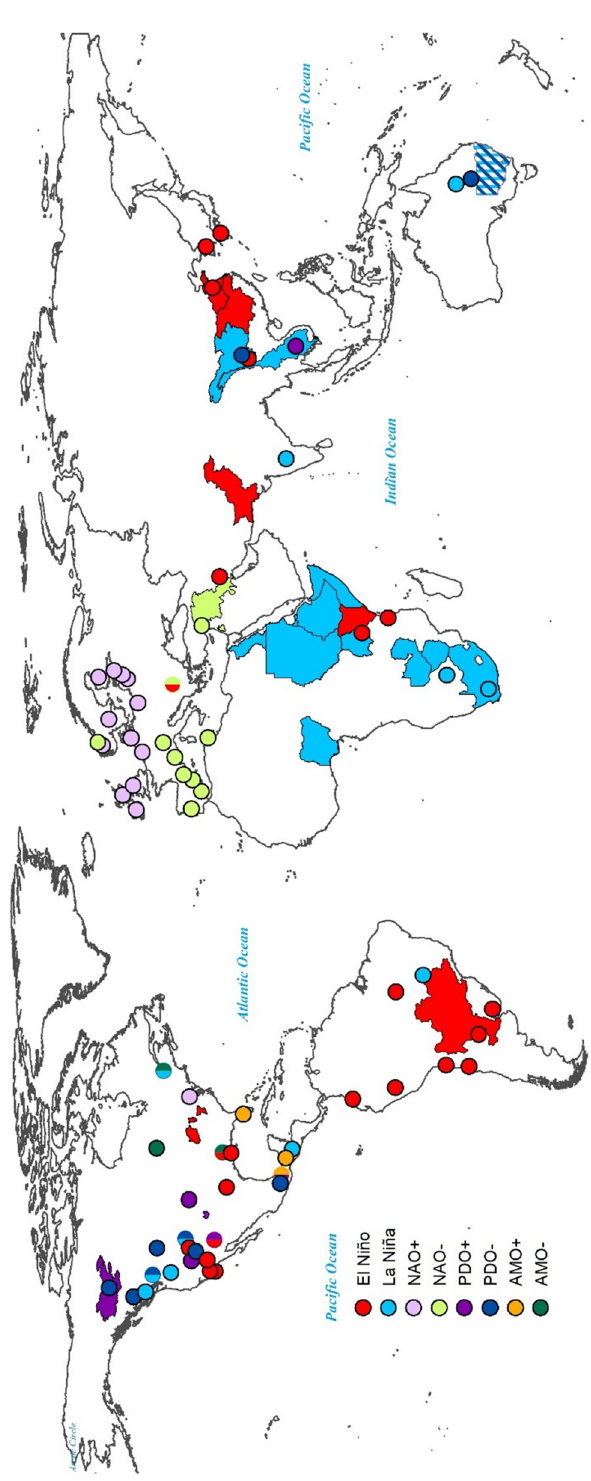
Figure 1. Map of regional predisposition to abundance of water.